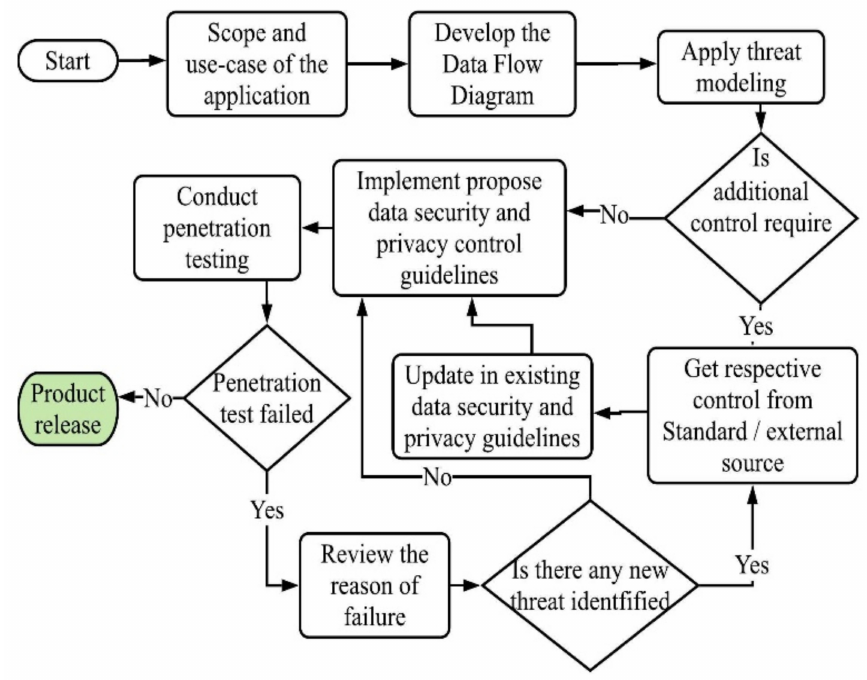
Figure 4. Implementation process of the data security and privacy